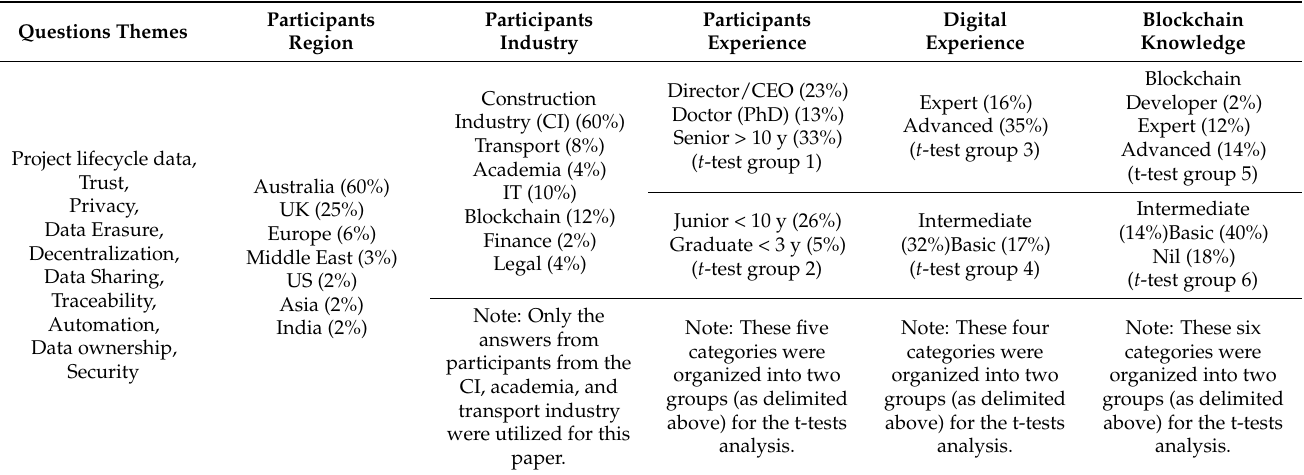
Table 6. Summary of the survey themes and the data profile, including regions, roles, and experience.